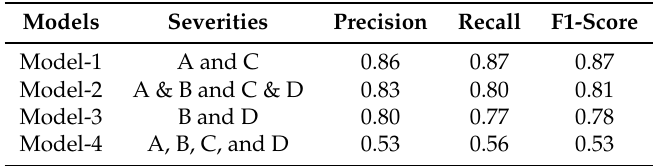
Table 2. Initial model selection results from the severity categorization model for different combinations of severities. Results reported are macro-averaged.